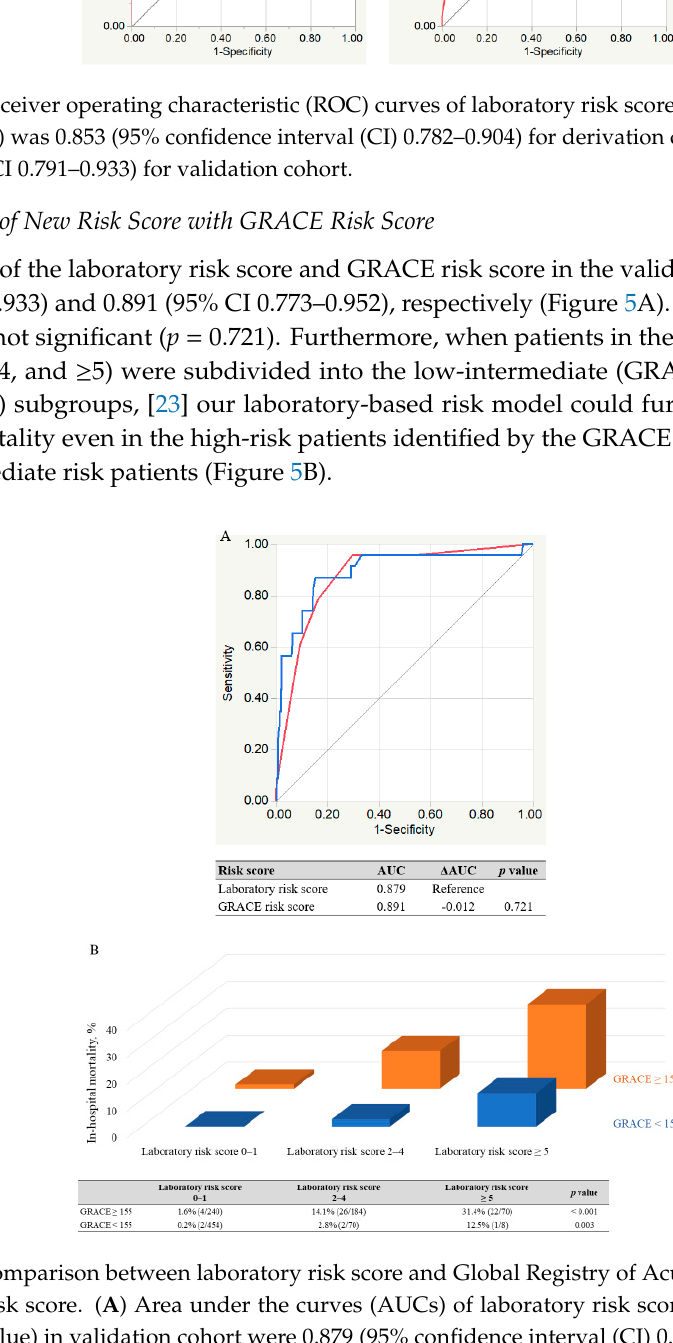
Figure 4. Receiver operating characteristic (ROC) curves of laboratory risk score. ( A ) Area under the curve (AUC) was 0.853 (95% confidence interval (CI) 0.782–0.904) for derivation cohort. ( B ) AUC was 0.879 (95% CI 0.791–0.933) for validation cohort.